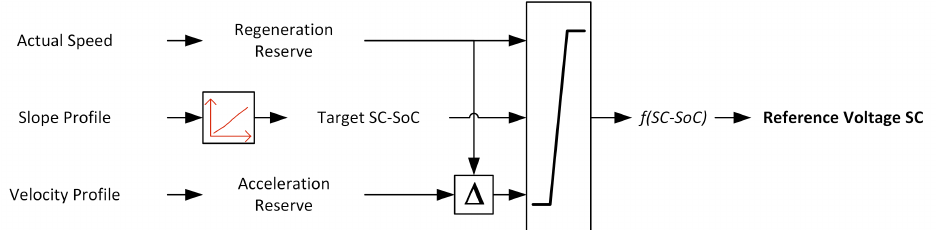
Figure 6. Calculation of the reference voltage for the